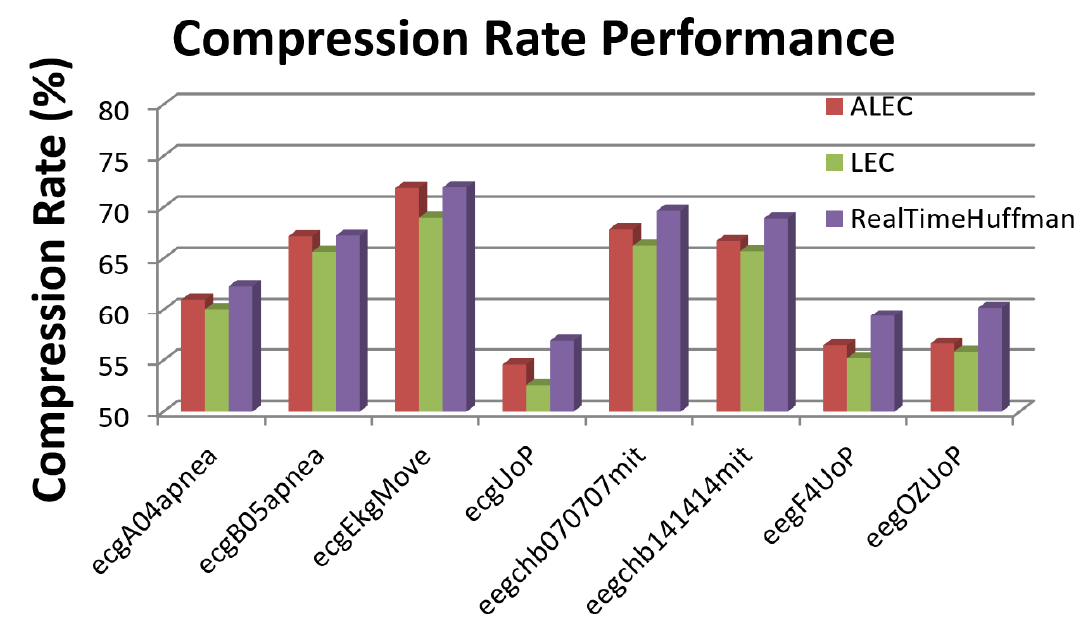
Figure 2. Compression rate performance evaluation. Table 1. Processing delay performance